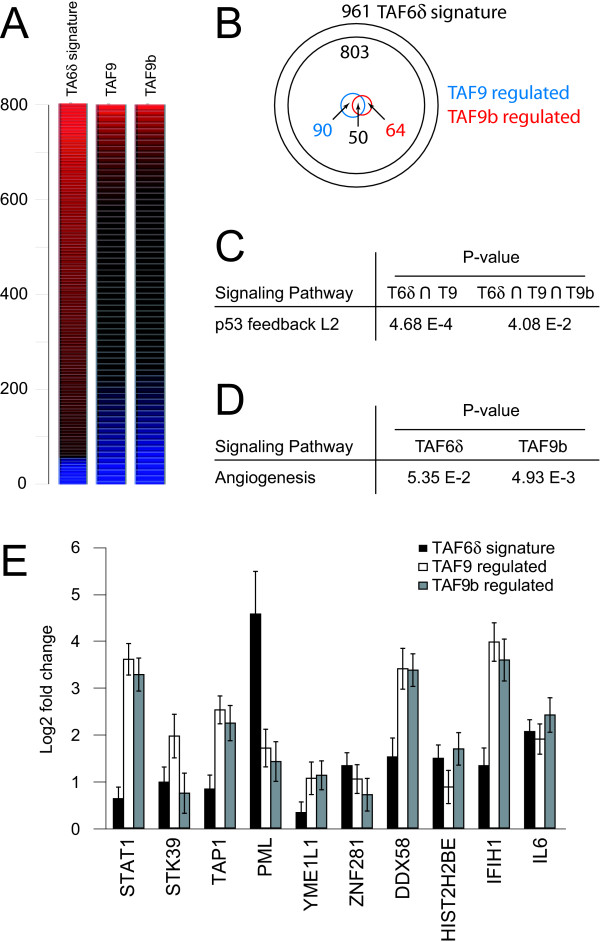
Comparison of the transcriptome effects of TAF6δ with TAF9 and TAF9b. (A) A heat map representation of changes in expression of 800 mRNAs that could be mapped from the published data resulting from depletion of TAF9 or TAF9b [16] to the TAF6δ-dependent transcriptome signature shows the global comparison of their respective transcriptome profiles. The red gradient indicates positive, and the blue gradient negative fold changes in expression. (B) A Venn diagram representation of the transcriptome comparison shows the relationship between genes significantly regulated by TAF6δ, TAF9 and TAF9b. 803 probes were mapped onto the 961 probe TAF6δ signature. (C) Overrepresentation of the "p53 feedback loop 2" gene ontology pathway is common to the TAF6δ, TAF9 and TAF9b signatures. Pathway analysis was performed as described in Materials and Methods for genes significantly regulated by both TAF6δ and TAF9 (left), by all of TAF6δ, TAF9 and TAF9b (right). P-values for overrepresentation are shown in the table. (D) Overrepresentation of the angiogenesis gene ontology pathway is common to the TAF6δ, TAF9 and TAF9b transcription signatures. Pathway analysis as in (C). (E) Microarray recorded gene expression changes for examples of genes similarly regulated by TAF6δ, TAF9 and TAF9b are shown. Error bars indicate standard deviations.